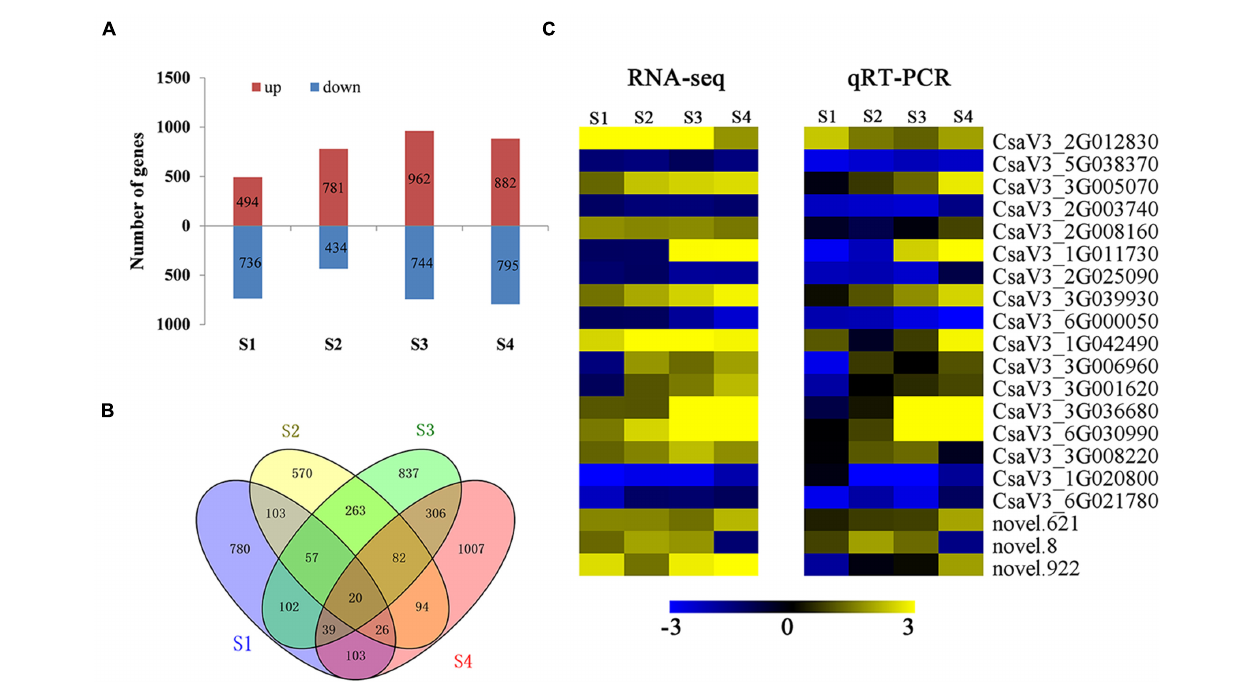
FIGURE 4 | Differentially expressed genes (DEGs) in HS compared with CK at anther development stages. (A) Number of up and downregulated DEGs in a HS compared with CK. (B) Venn diagram of DEGs in HS compared with CK. (C) Expression patterns of common DEGs by RNA-seq and